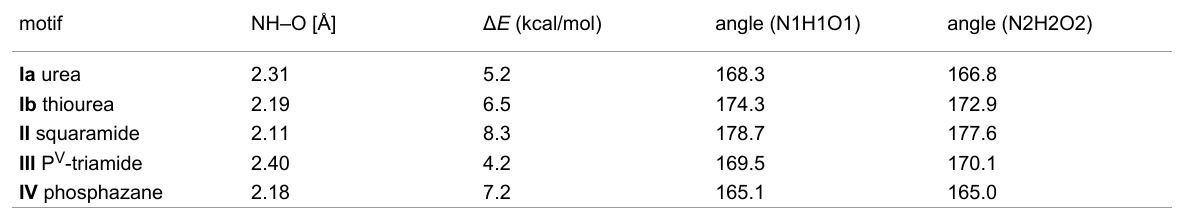
Table 1: Computational a comparison of HB catalyst motifs (cf. Figure